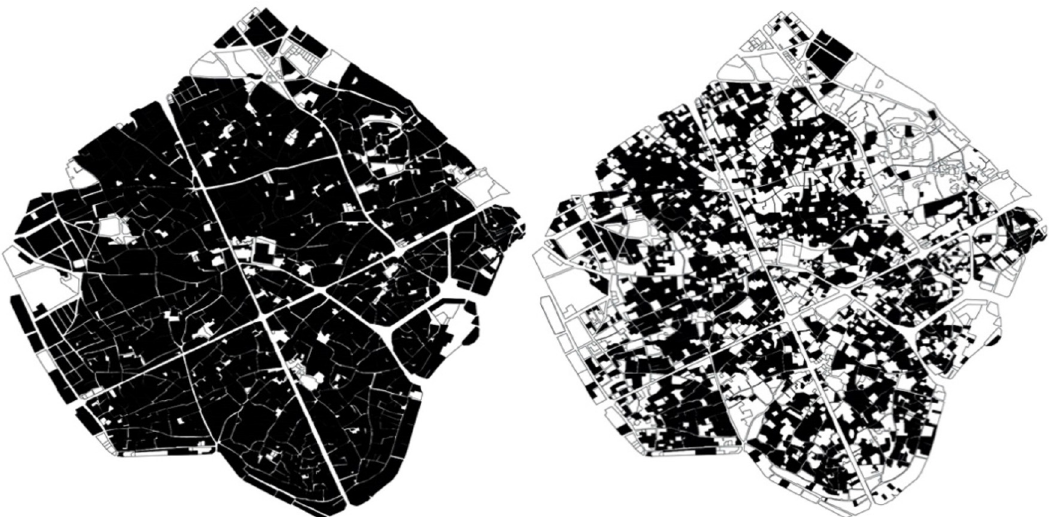
Fig. 4. Left (cid:1) Old City Plan before the con fl ict; right- after the con fl ict showing the scale of destruction, open spaces are the buildings which are severely or completely destroyed. Those are the areas that need to be